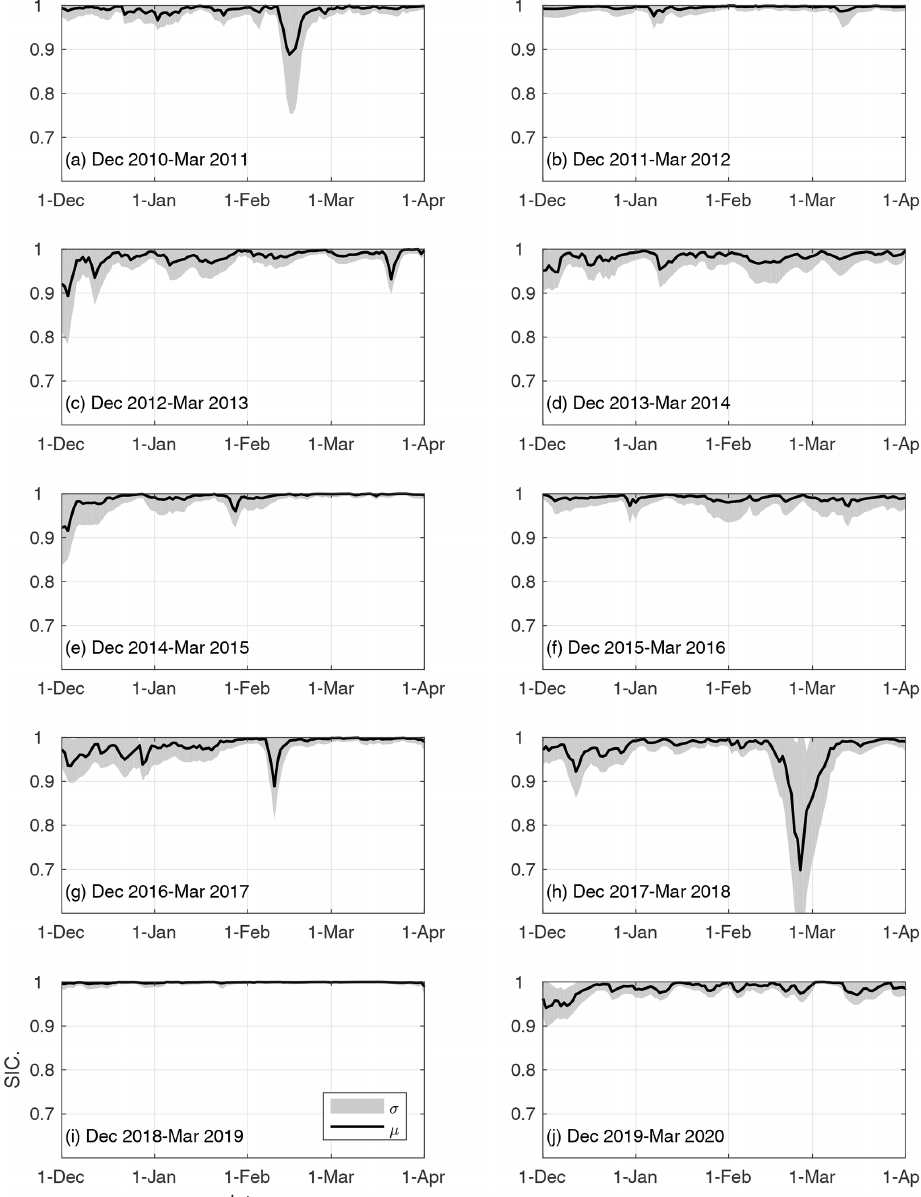
Figure 7. (a–j) Satellite-derived (NASA team algorithm) daily mean (µ) sea ice concentration (SIC) (black) for the northern Greenland region (see Fig. 4a) during January–March from 2011 to 2020. The gray shading depicts 1 standard deviation ( σ ) (gray) from the mean